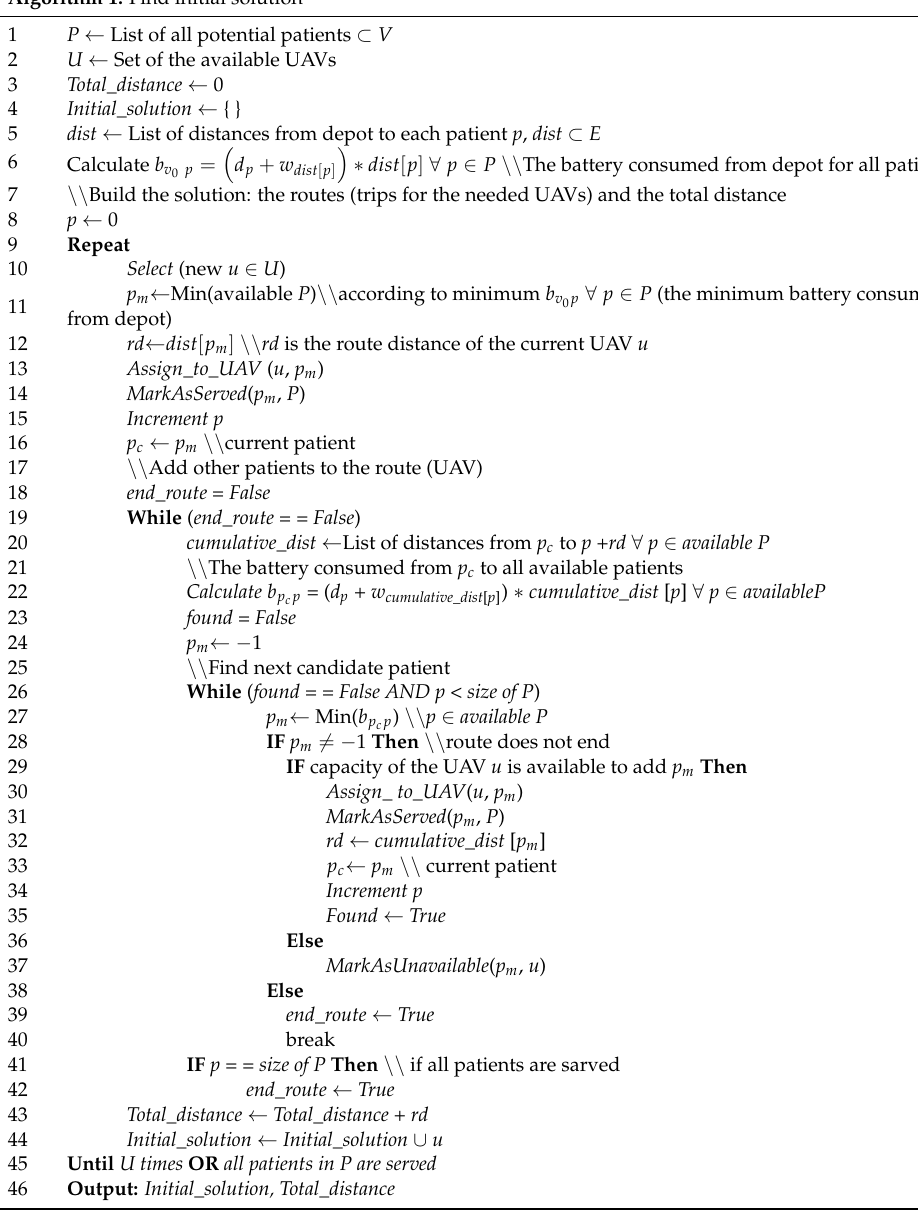
Algorithm 1. Find initial